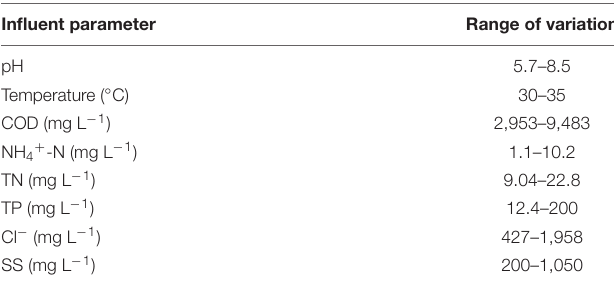
TABLE 1 | Physicochemical parameters of